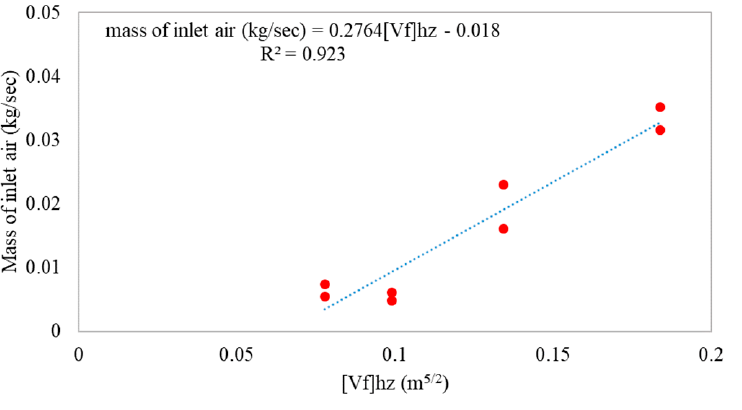
Figure 22. Average compartment inlet fresh air during steady state period as a function of the updated ventilation factor.